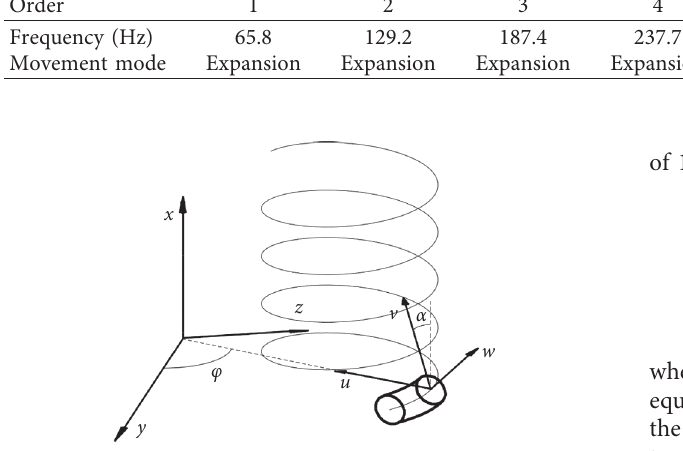
Figure 2: Coordinate system of a coil